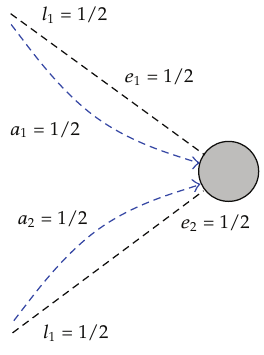
Figure 2: Example of node that is feasible connected w.r.t. its incoming arcs, but not w.r.t. Inequalities (cid:6) e (cid:6) 1 / 2 in the current LP-solutions, but as both edges have assigned the same label (cid:2) 3.22 (cid:3) . Edges e 1 2 (cid:6) 12 the sum over the set of all labels assigned to incident edges of the considered node is also 1/2. Such l 1 situations are forbidden by Inequalities (cid:2) 3.22 (cid:3) .